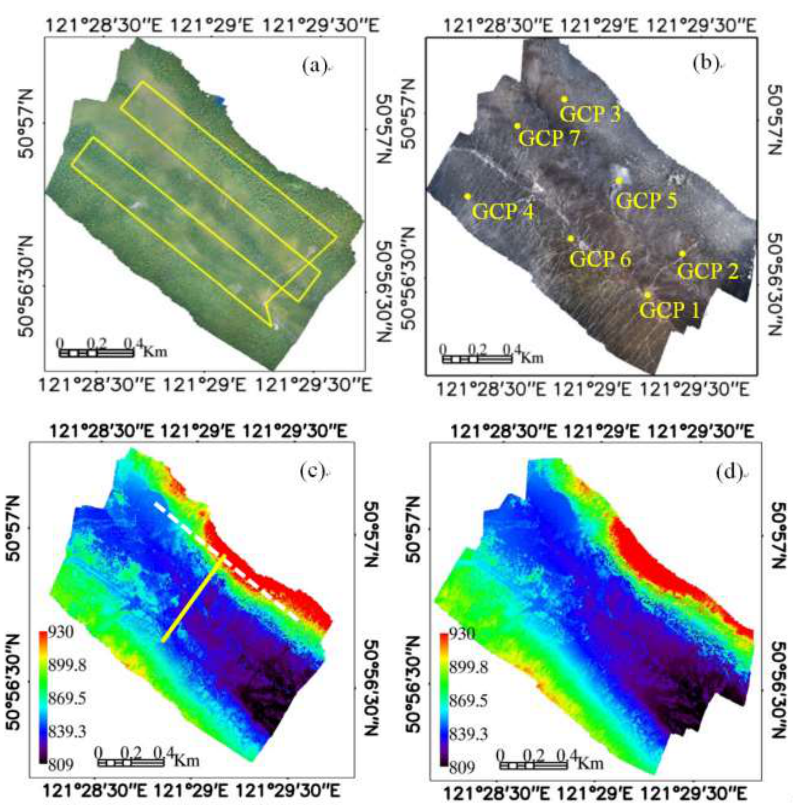
Figure 3. Ortho-rectified mosaic images and digital surface model (DSM) of UAV stereo imagery acquired in leaf-on and leaf-off conditions (pixel size 8.6 cm). ( a ) the mosaic image of leaf-on with the flying trajectory showed as yellow lines; ( b ) the mosaic image of leaf-off with ground control points (GCPs) used in the stereoscopic processing showed as yellow dots; ( c ) the digital surface model of stereo imagery acquired on leaf-on season, the dash and solid lines indicates positions of two profiles used in the following sections; ( d ) the digital surface model of stereo imagery acquired on leaf-off season;.